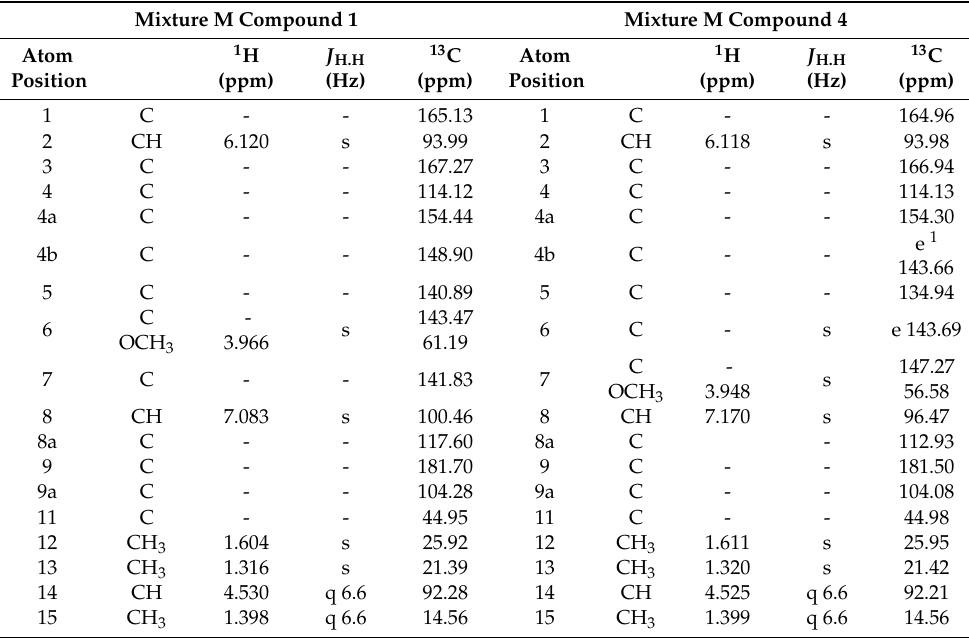
Table 1. 1 H- and 13 C-NMR data of mixture M in CD 3 OD.